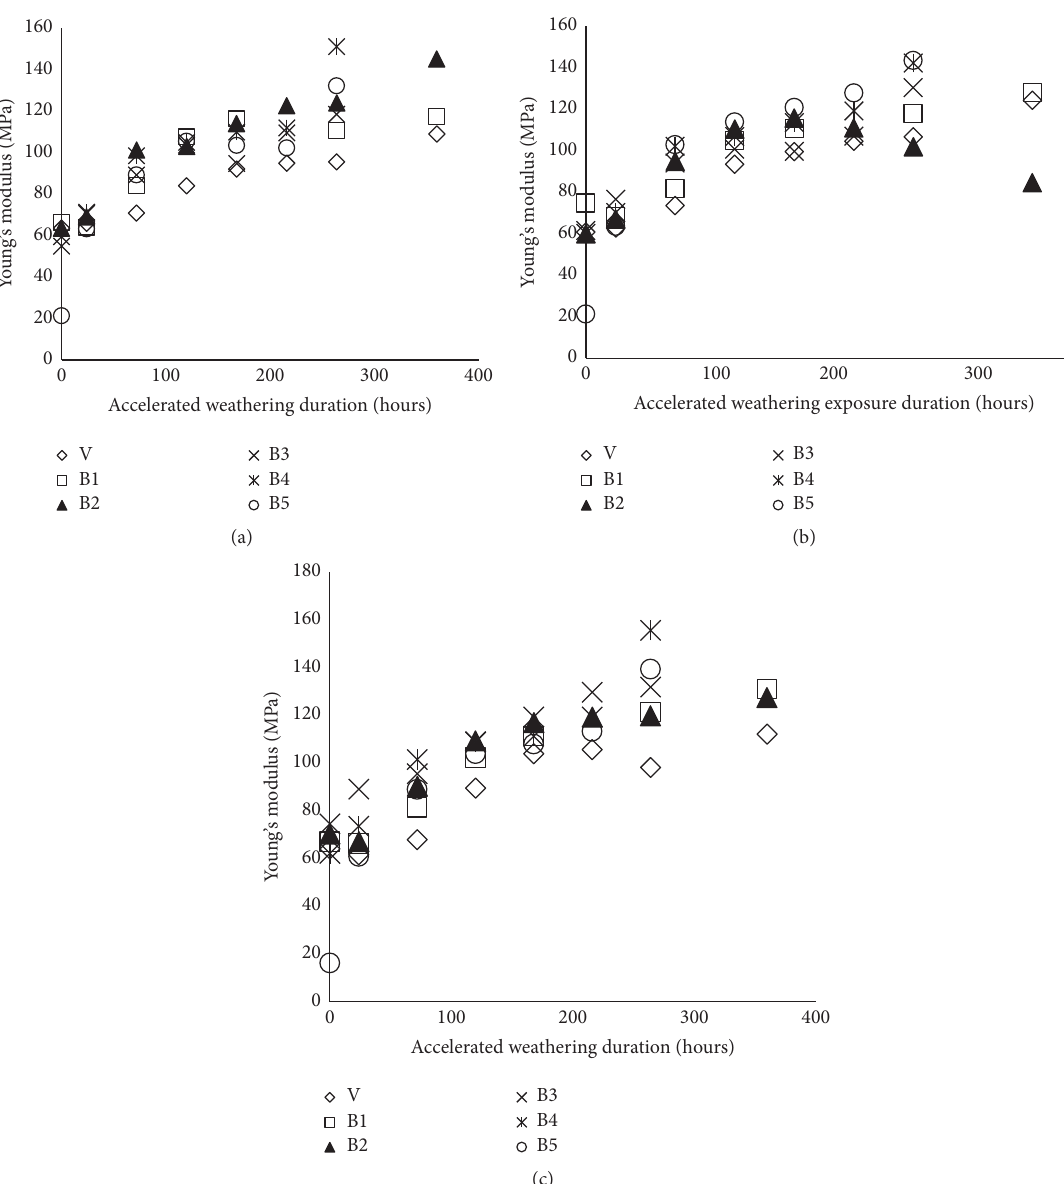
Figure 4: Young’s modulus of the formulated samples with respect to accelerated weathering duration (hours). Samples processed with a Die Head Temperature (DHT) = 175, 185, and 195 ∘ C are shown in (a), (b), and (c),